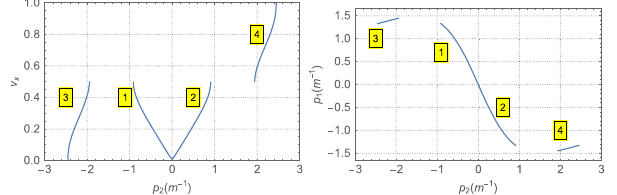
FIG. 6. Horizontal emittance as a function of the second quadrupole ’ s strength (left) and as a function of tune (right).